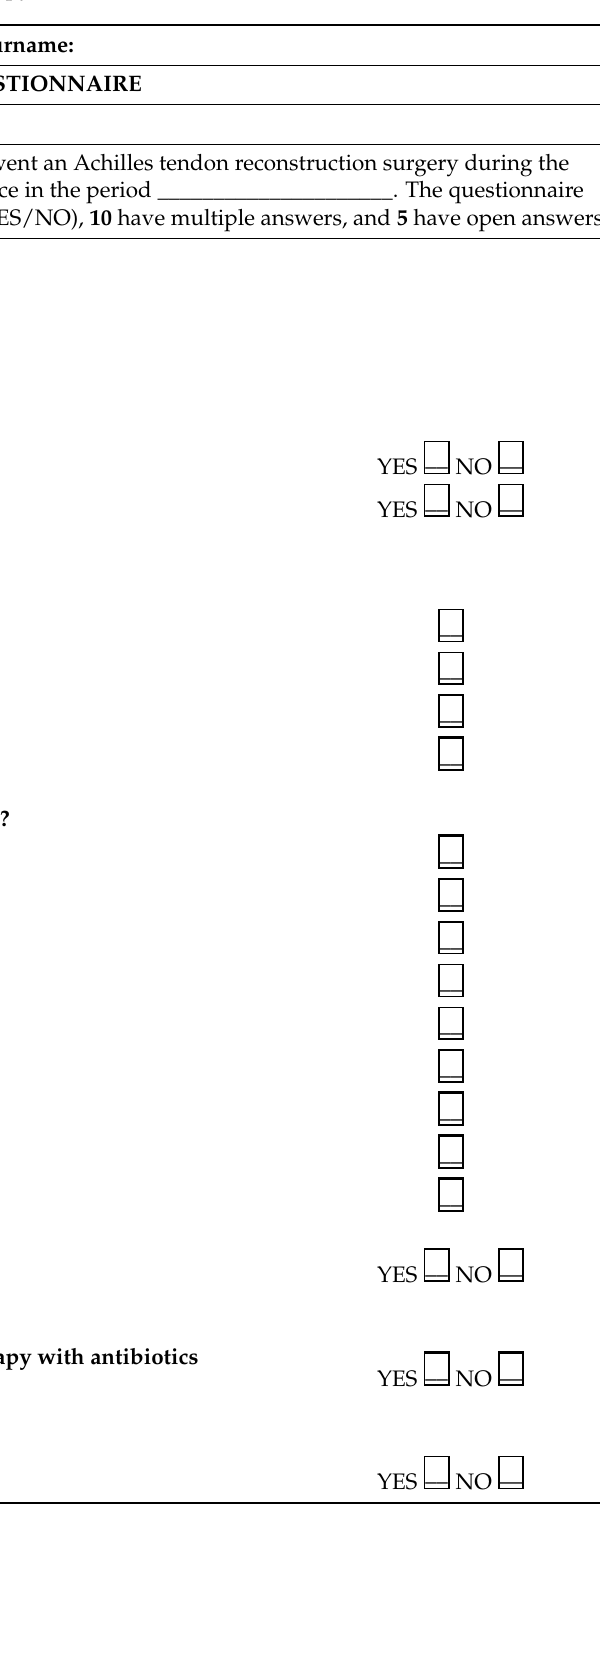
Table 1. Telephone questionnaire administered to the participants. Note: BMI = Body Mass Index; HRT = Hormone Replacement